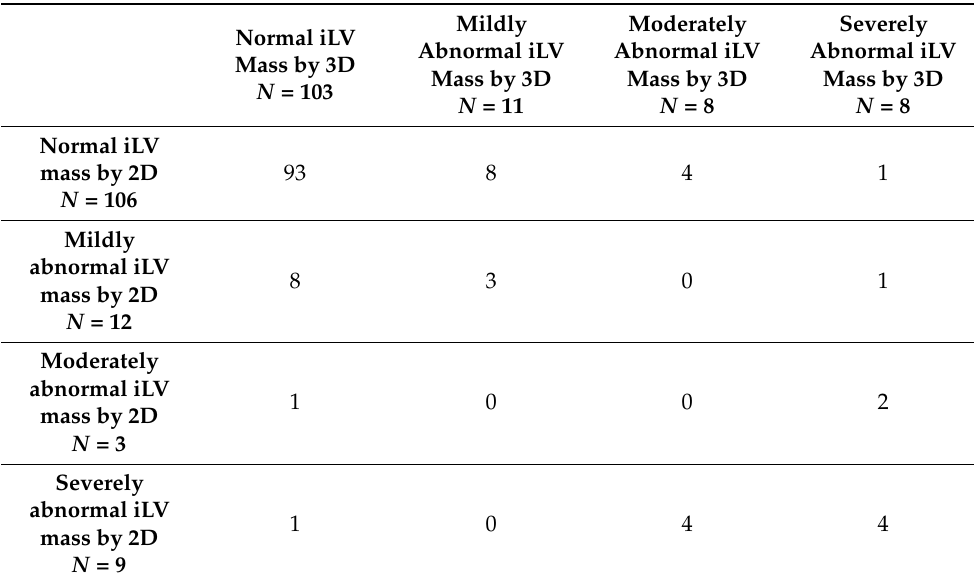
Table 4. Different distributions of LV mass categories applying 2D-linear vs. 3D measurements.